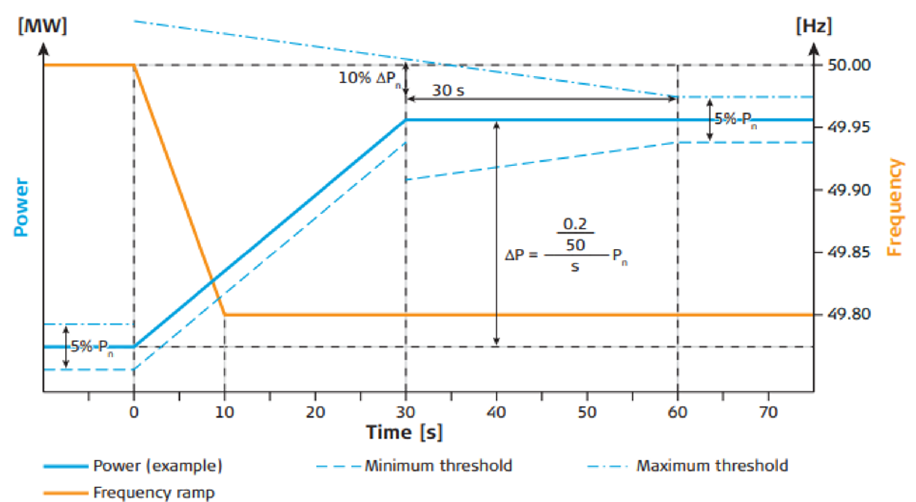
Figure 7. Tolerance band of the Swissgrid qualification